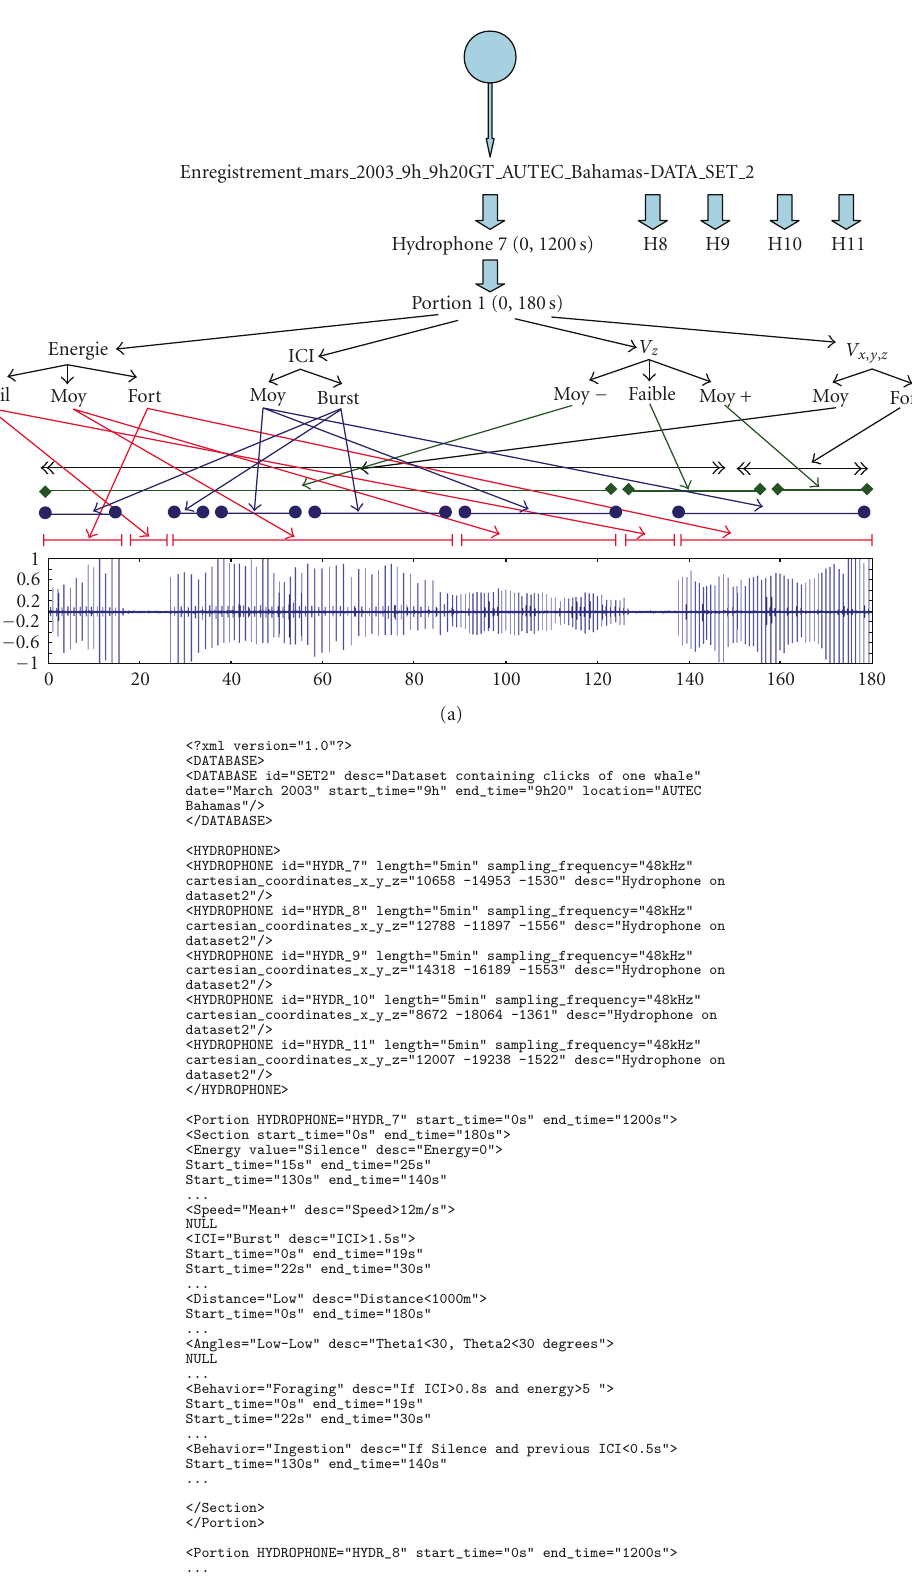
Figure 8: At (a), XML structure of the hydrophones recordings. At (b), part of an XML whale record analysis including behavior tags. For each tag is attributed a quantitative or qualitative value and also the start and end